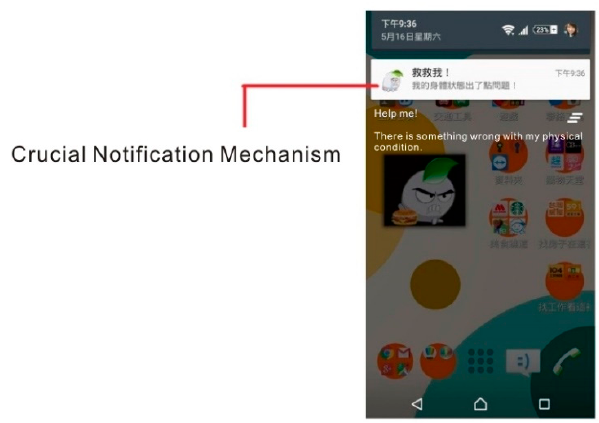
Figure 9. Crucial notification mechanism.